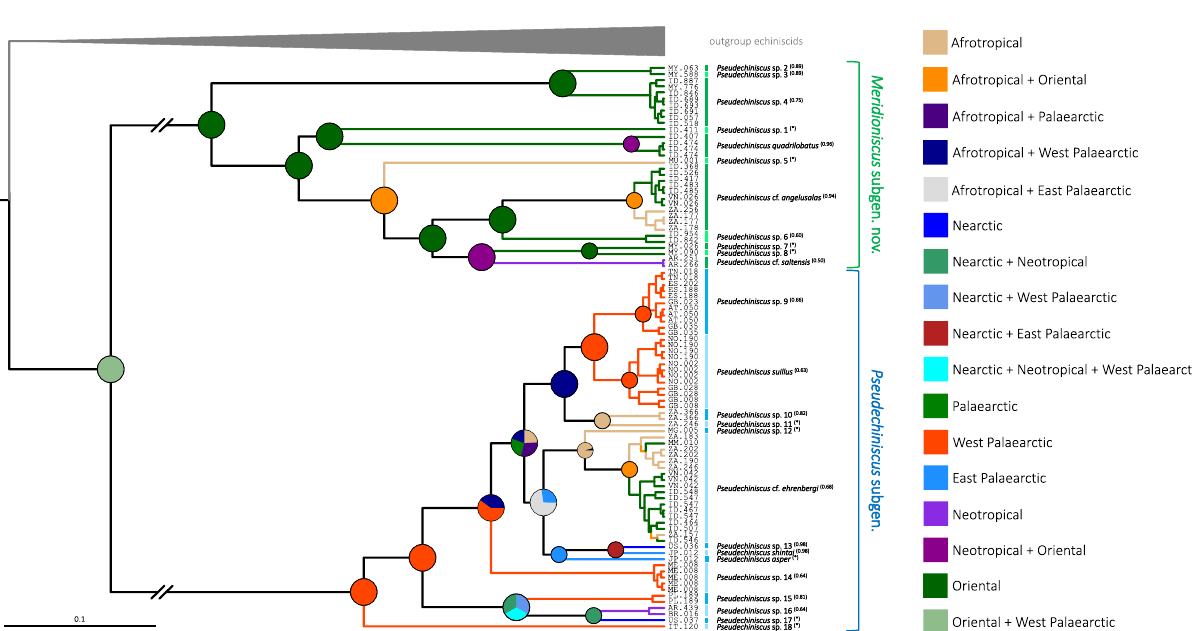
Figure 6. Historical biogeography of Pseudechiniscus reconstructed using S-DIVA. Nodal pie charts show relative probabilities of historical geographic ranges according to the in-figure colour legend. Black colour signifies unexplained